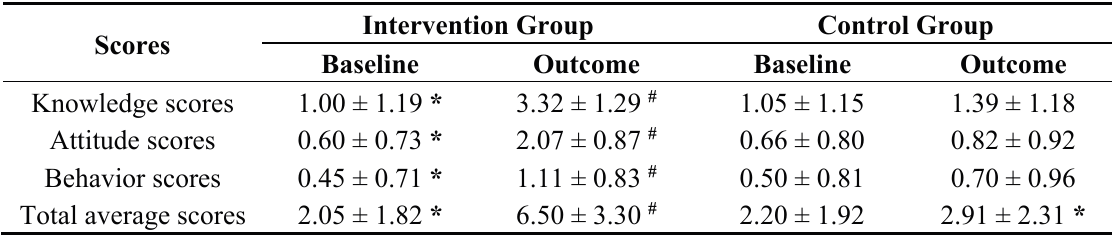
Table 5. Comparison of the knowledge, attitude and behavior score between baseline and outcome from intervention and control groups ( x ±